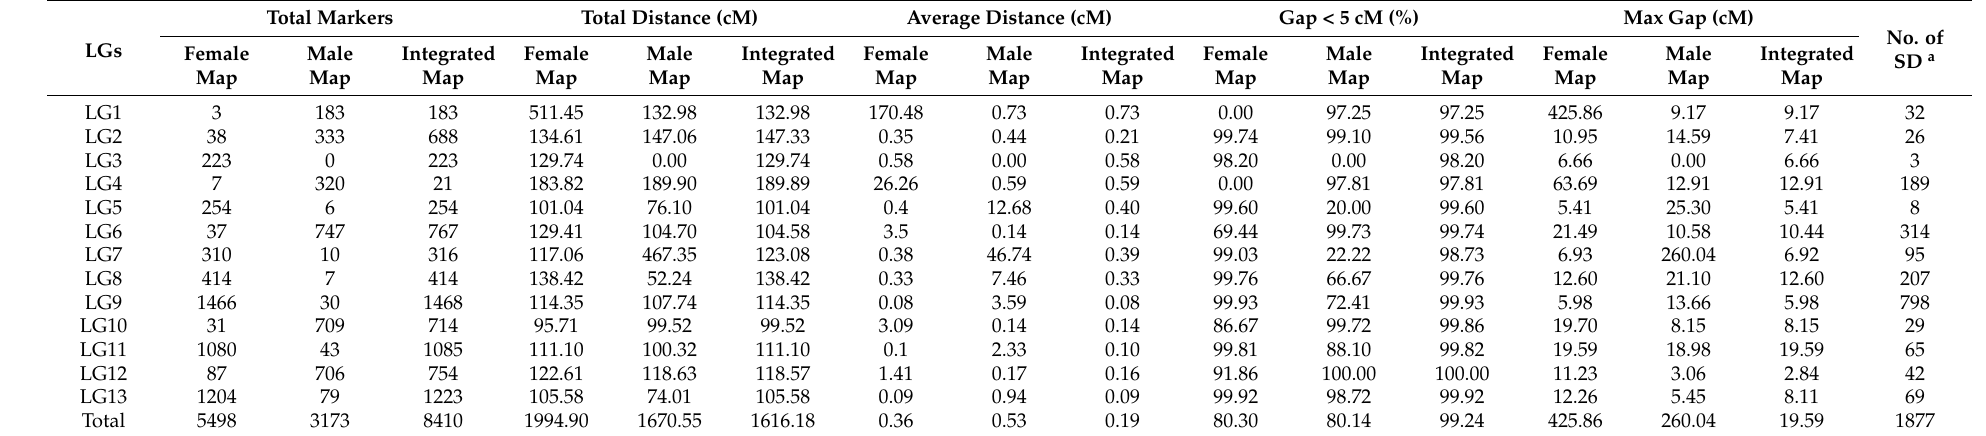
Table 5. Description of the basic characteristics of the 13 linkage groups in Paphiopedilum